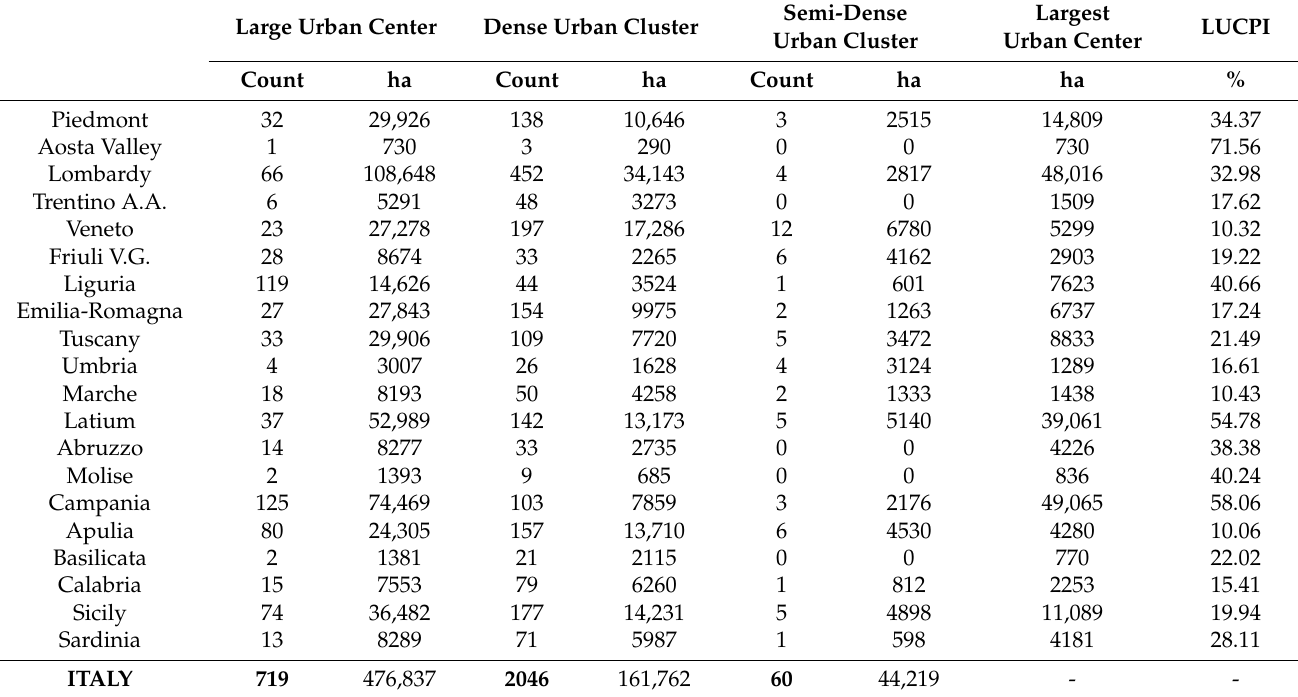
Table 5. Surface and number of clusters present on the Italian territory for the three classes of Urban Centers, Dense Urban Clusters, and Semi-Dense Urban